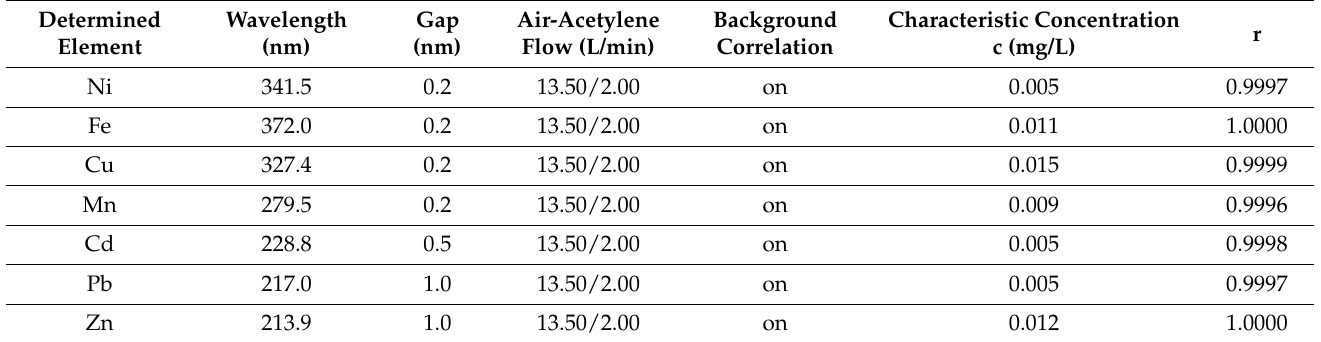
Table 1. Measurement parameters applied according to the authors’ previous study